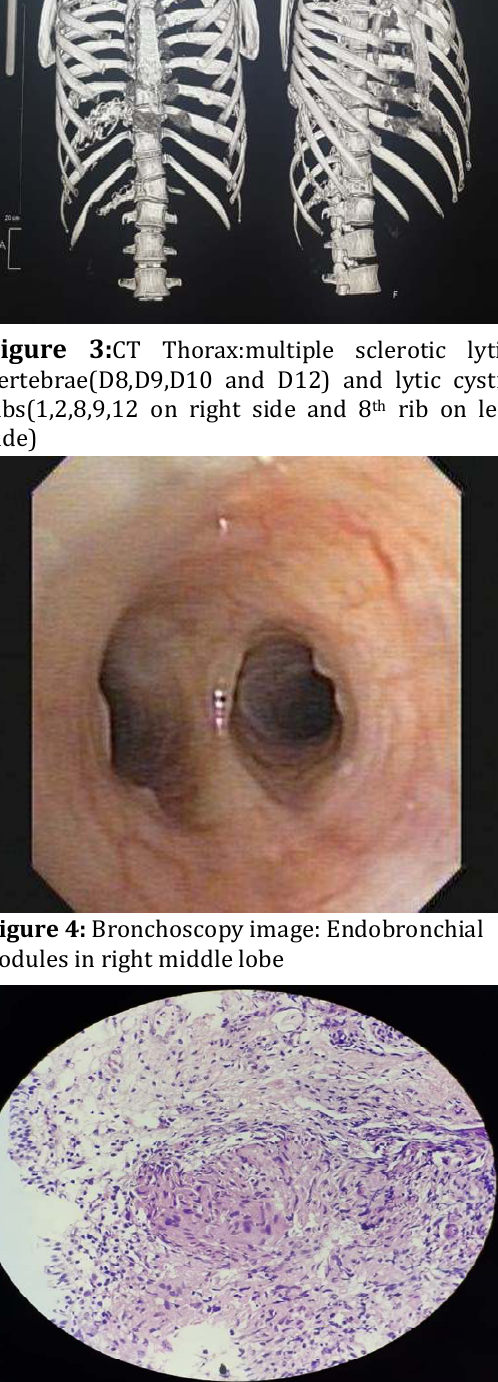
Figure 5: HPE: epitheloid cell granulomas with few Langerhan’s giant cells and at places Schaumann like bodies seen with incoscpicuous necrosis, suggestive of